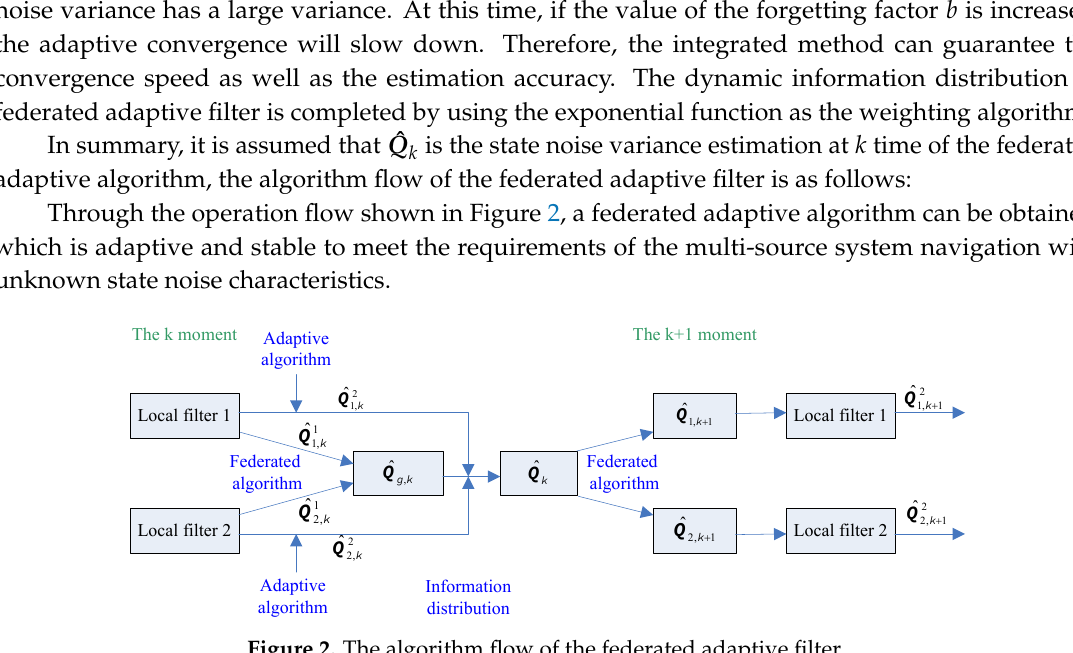
Figure 2. The algorithm flow of the federated adaptive